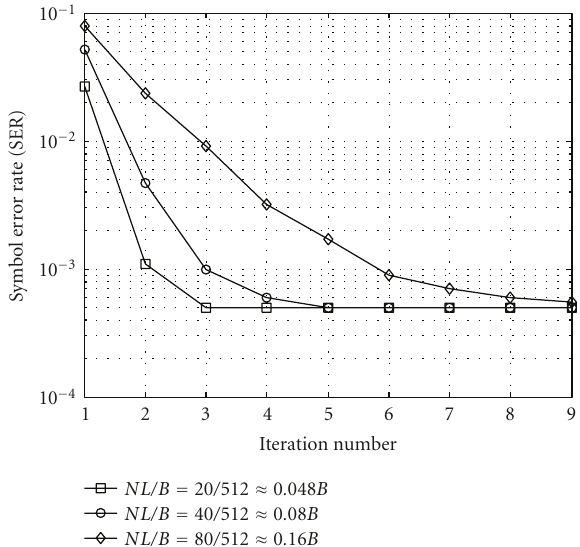
Figure 7: SER of the iterative symbol detection versus the iteration number under SNR = 24 dB, E p = 0 . 01E s